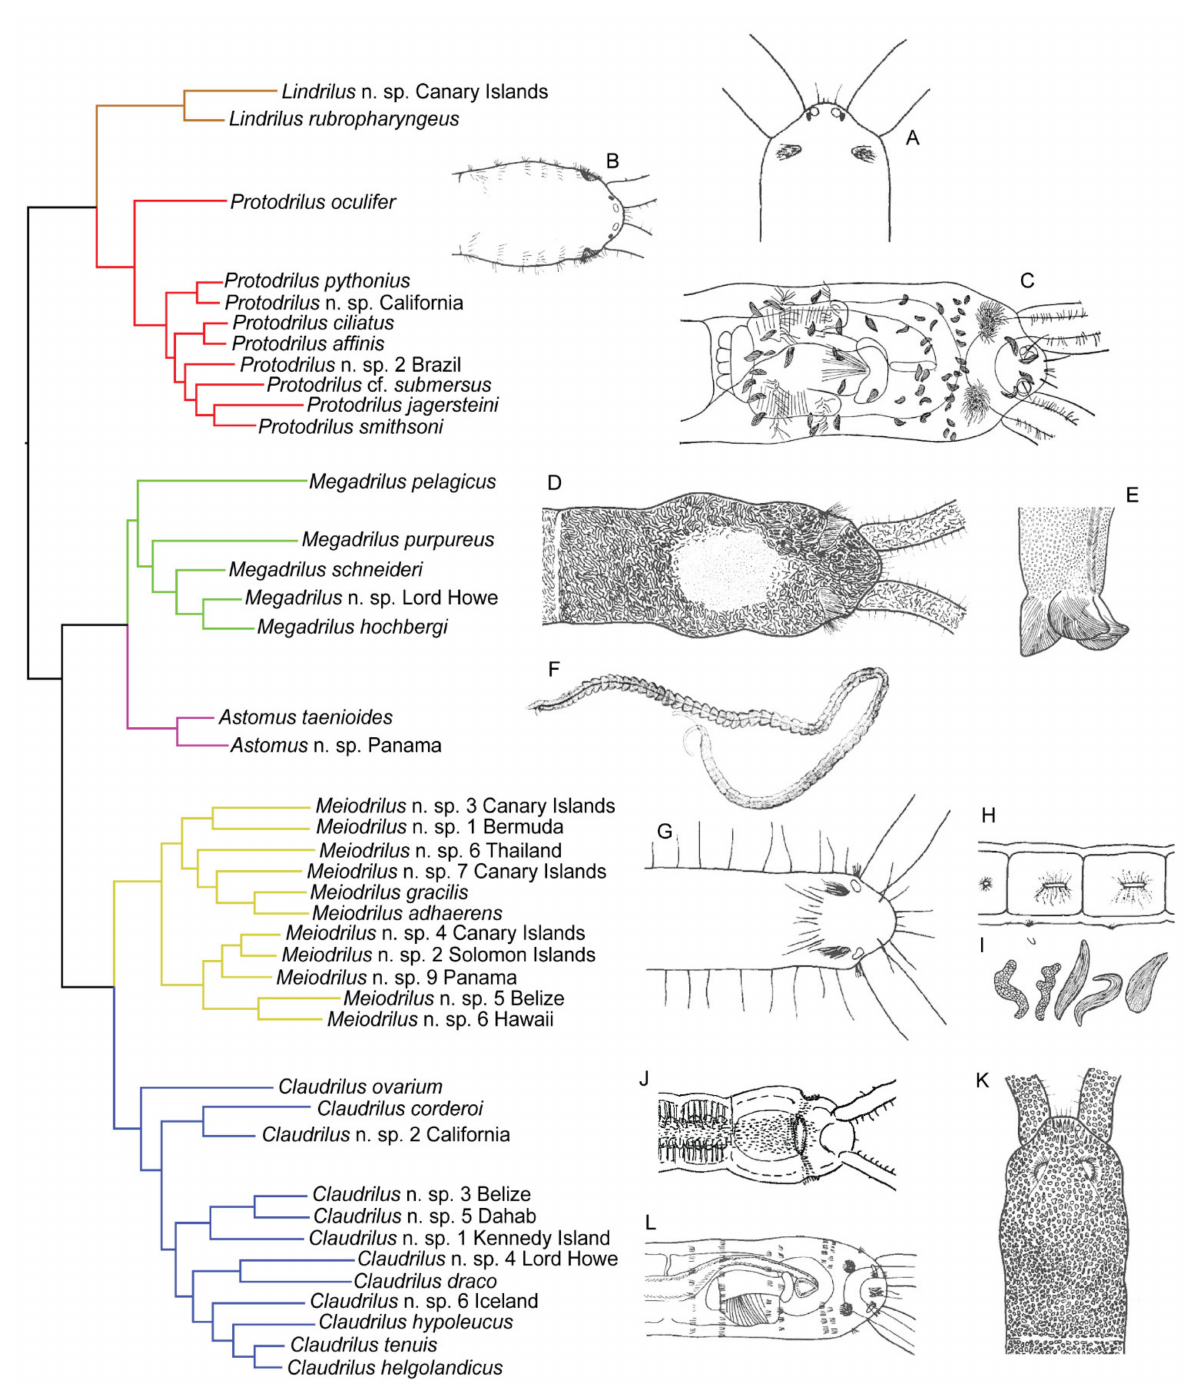
Figure 10. Diagram showing the phylogenetic relationships of Protodrilidae based on four molecular markers (18S rRNA, 28 rRNA, COI, H3) and morphology analyzed with maximum likelihood methods (Redrawn from [50], along with illustrations representing the diagnostic characters for each genus. ( A ) Lindrilus rubropharyngeus, anterior end showing the presence of eyes, ciliated organs and the shape of the nuchal organs ( B ) Protodrilus oculifer, anterior end showing the presence of eyes and ciliated unpigmented organs. ( C ) Protodrilus albicans, anterior end. ( D ) Megadrilus purpureus, anterior end. ( E ) Megadrilus purpureus and its characteristic trilobed pygidium. ( F ) Astomus taenioides, showing the festooned trunk segments. ( G ) Meiodrilus adhaerens, anterior end. ( H ) Meiodrilus adhaerens, lateral organs. ( I ) M. adhaerens, cocoon glands. ( J ) Claudrilus corderoi, anterior end. ( K ) Claudrilus hypoleucus, anterior end showing the epidermal glads. ( L ) Claudrilus hypoleucus, anterior end. A, redrawn from [191]; ( C , L ), redrawn from [28], ( D , K ), from [53]; ( F ), from [31], ( B , G – I ), from [192], ( J ) from